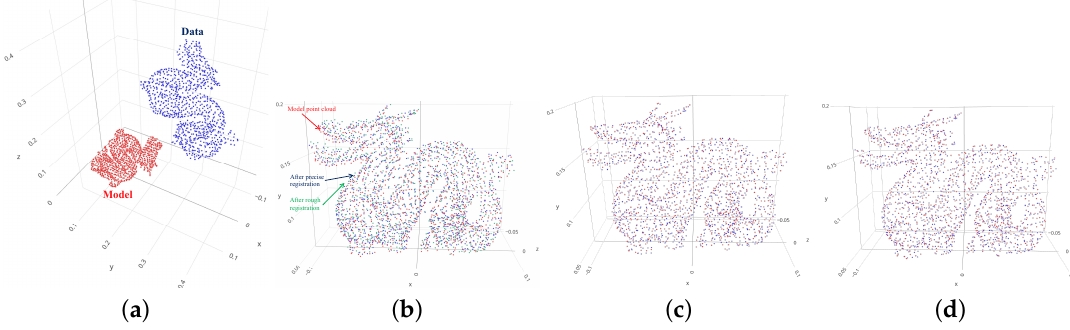
Figure 14. The registration results of Dragon data for test sample 20: ( a ) The initial state; ( b ) 3-D CNNs then 2-D CNNs, ( c ) RANSAC then ICP, ( d ) Fast Global Registration.